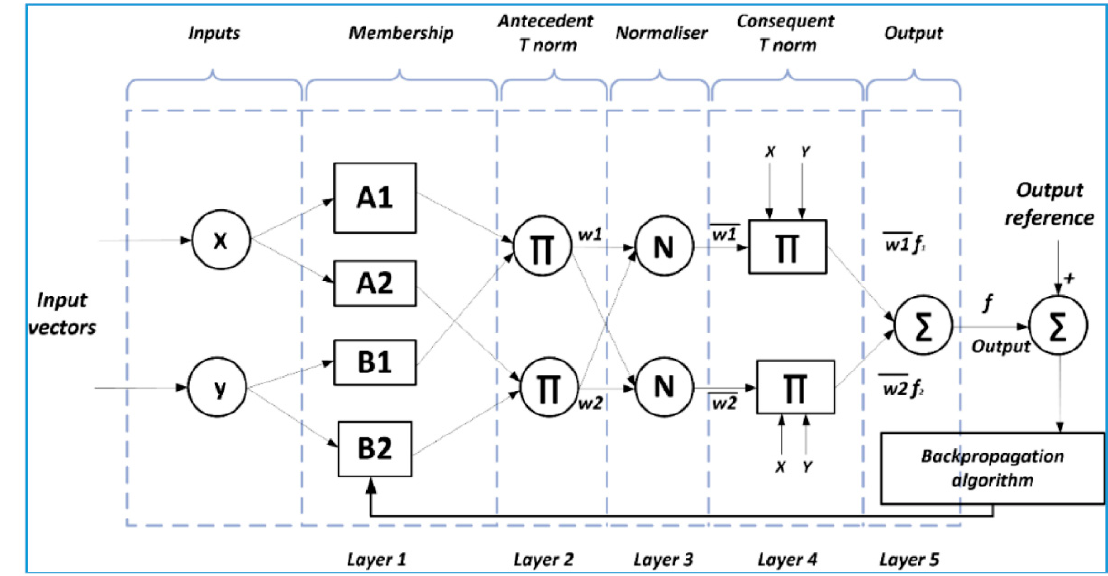
Figure 1. A schematic view of the intelligent adaptive neuro-fuzzy inference system (ANFIS).